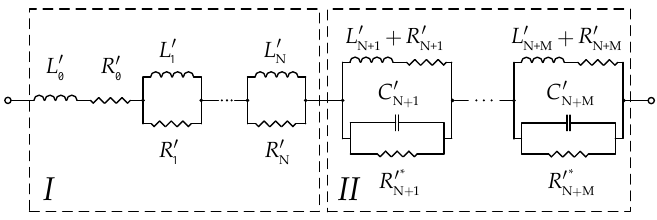
Figure 1. Representation of the frequency dependence of the cable longitudinal